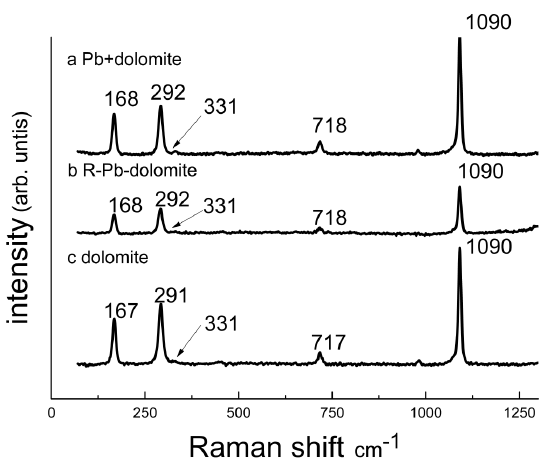
Figure 5. Mid – infrared spectra of dolomite powder: a dolomite after 15 d exposure to PbCl 2 solution; b dolomite after 15 d of re-dissolution after pretreatment with PbCl 2 solution. The Raman shifts in the dolomite powder exposed to PbCl 2 solution are similar to those of dolomite; however, at 168 cm −1 , 292 cm −1 , and 718 cm −1 , the Raman shifts are shifted in the short-wave direction compared to the initial dolomite powder. The pre- treated and redissolved dolomite powder has the same Raman shifts as the latter; see Fig- ure 6.